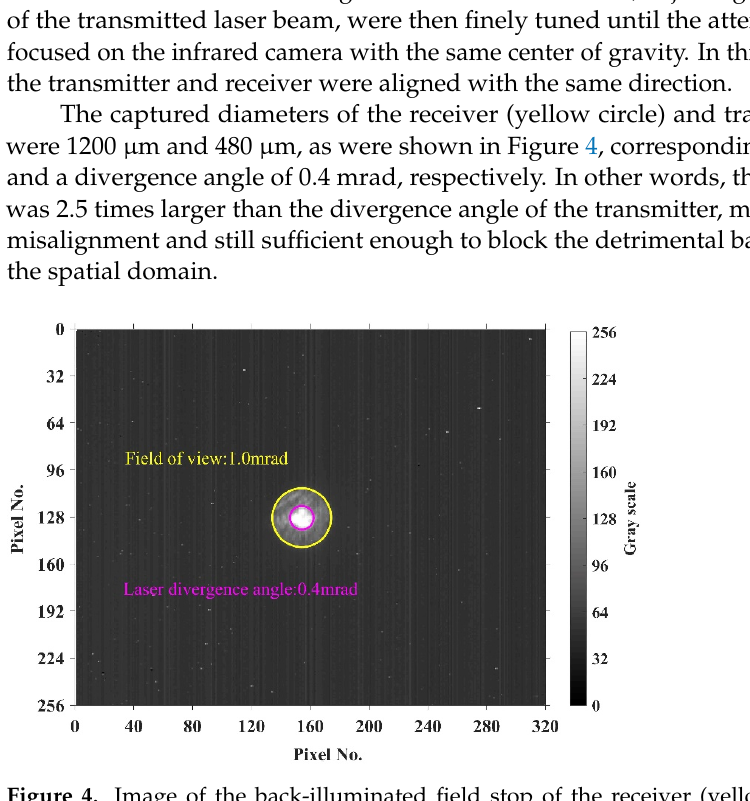
Figure 4. Image of the back-illuminated field stop of the receiver (yellow circle) and the laser transmitter (pink circle) captured from the infrared camera at the focal plane of the Newtonian telescope with focal length of 1.2 m.